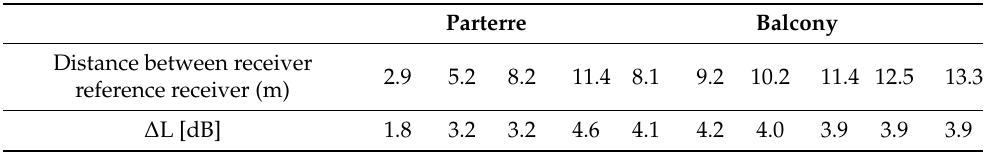
Table 7. Differences between sound pressure levels registered close to the source, obtained at a receivers’ line for music configuration use ( ∆ L).